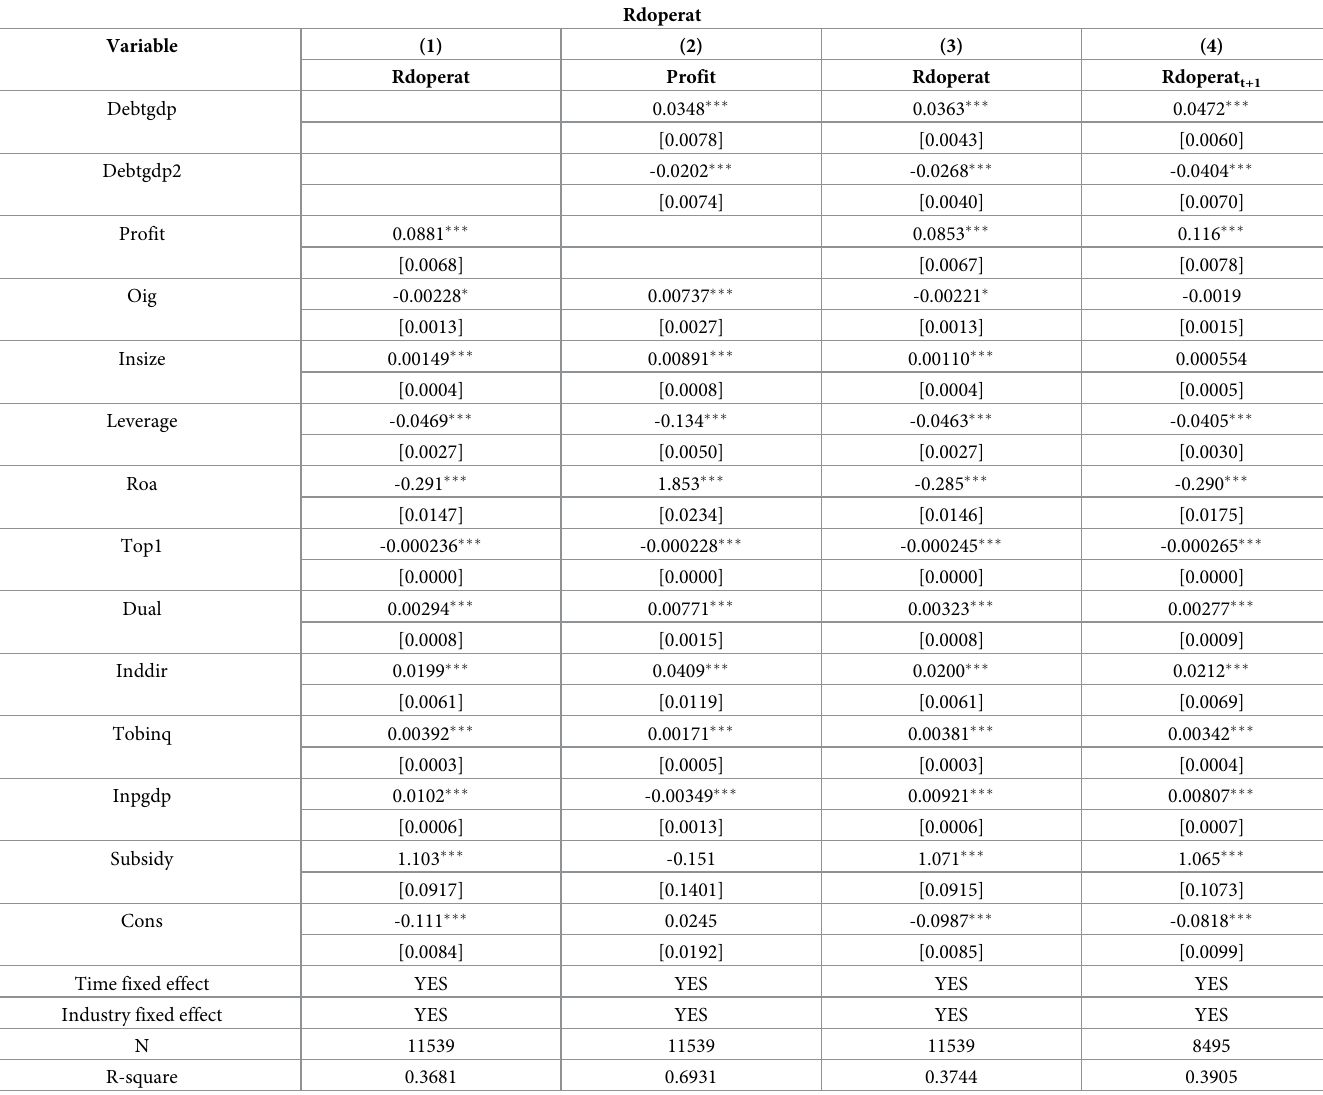
Table 6. Regression results of enterprise profit as the mediating